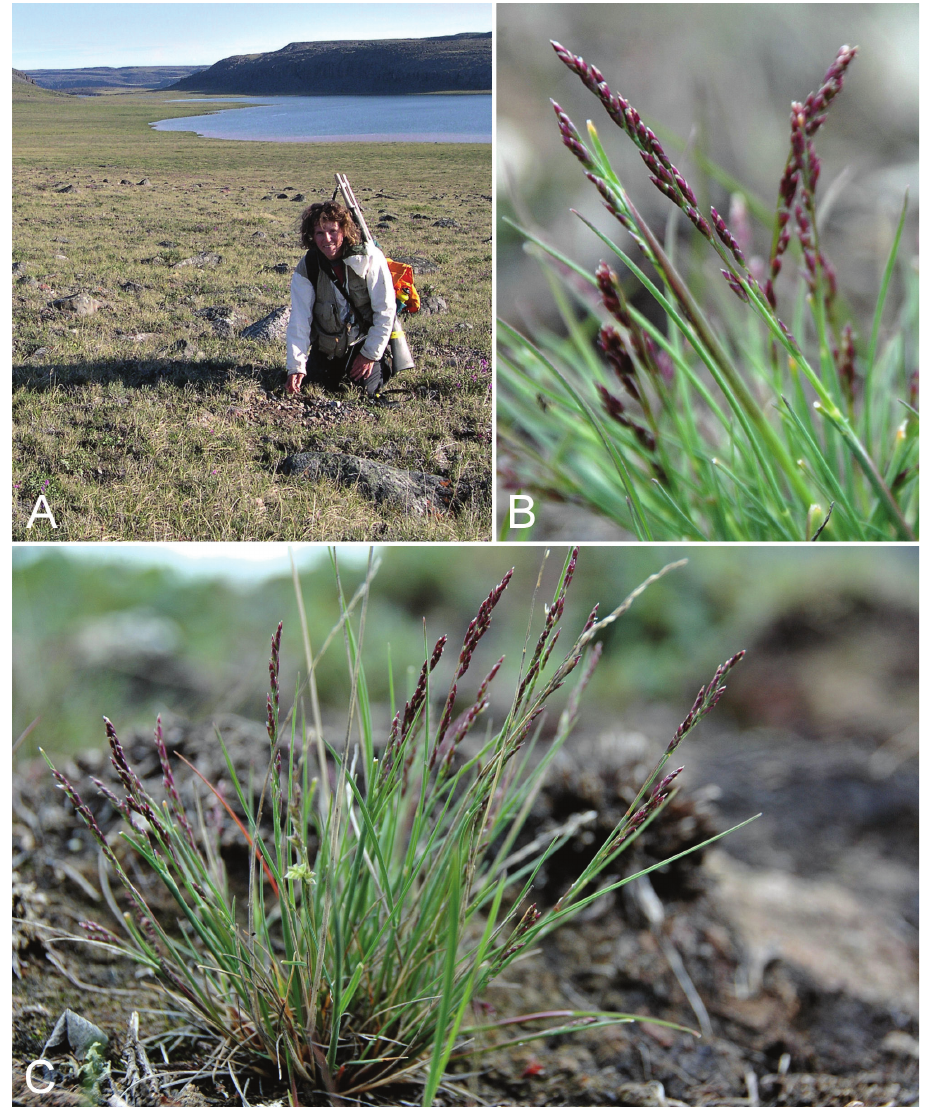
Figure 9. Puccinellia banksiensis : A habitat, with Laurie Consaul who described the species B inflorescence C habit, Gillespie et al 8055 . Photographs by L.J. Gillespie ( A ), R.D. Bull ( B, C